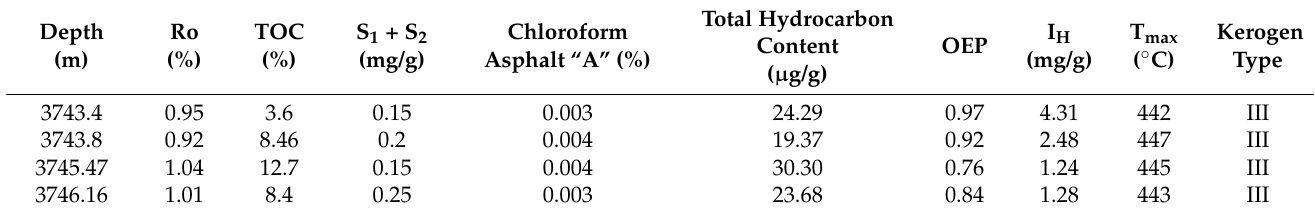
Table 1. Analysis results of YQ-1.